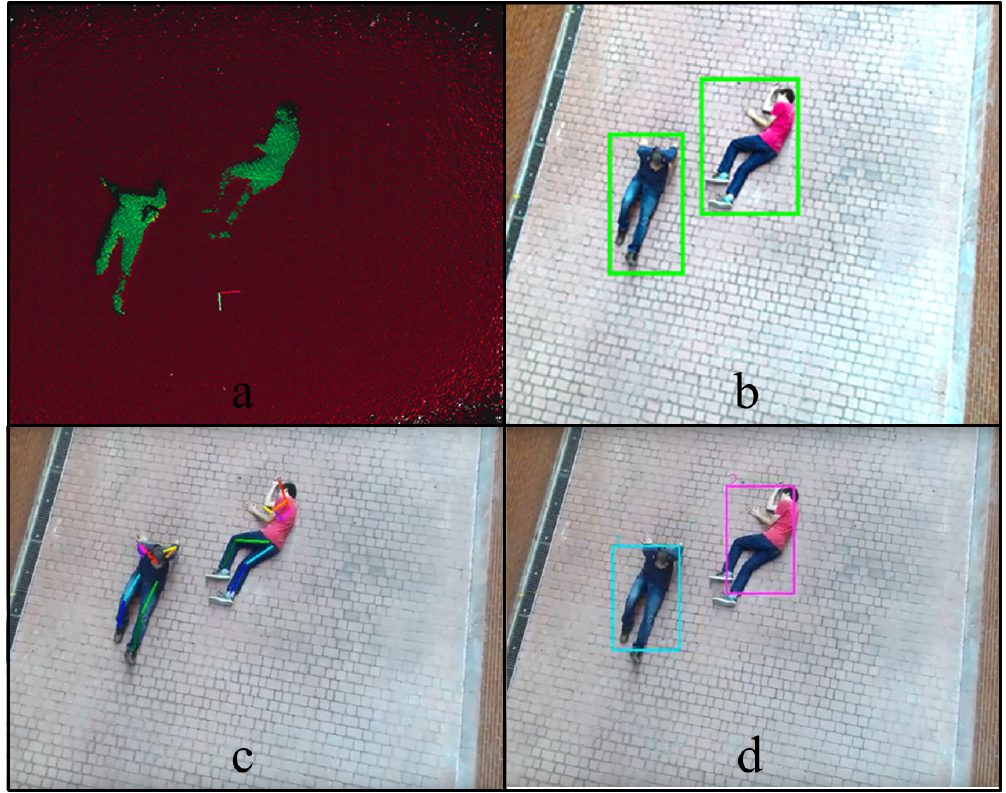
Figure 2. Proposed approach. ( a ) Floor removal stage; ( b ) object detections; ( c ) human pose filter analysis; ( d ) corresponding identity to every human